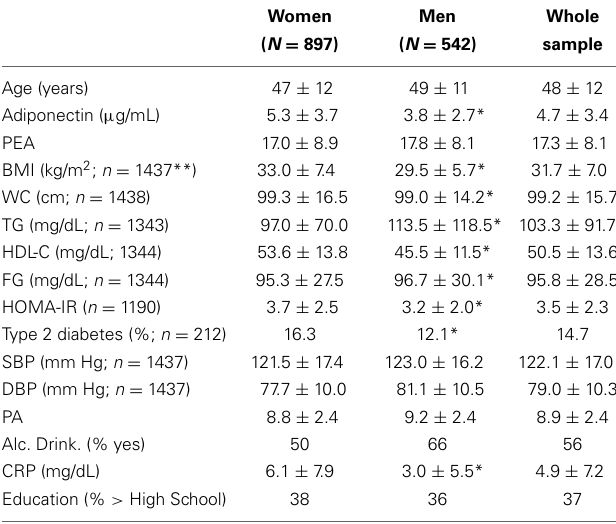
Table 1 | Descriptive characteristics (mean ± standard deviation, or percentage) of study participants ( N = 1439) stratified by